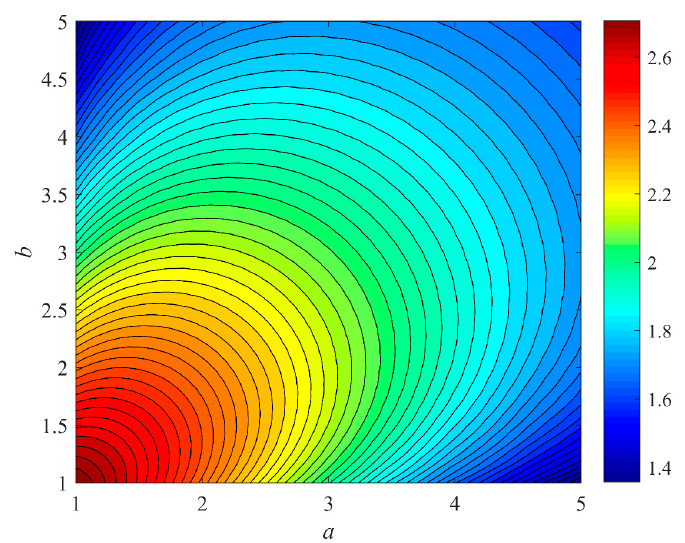
Figure 9. The shape entropies of cuboids with different edge length ratios of a and b , provided that c = 1. The blue area suggests a more irregular shape. The lower left corner corresponds to the regular